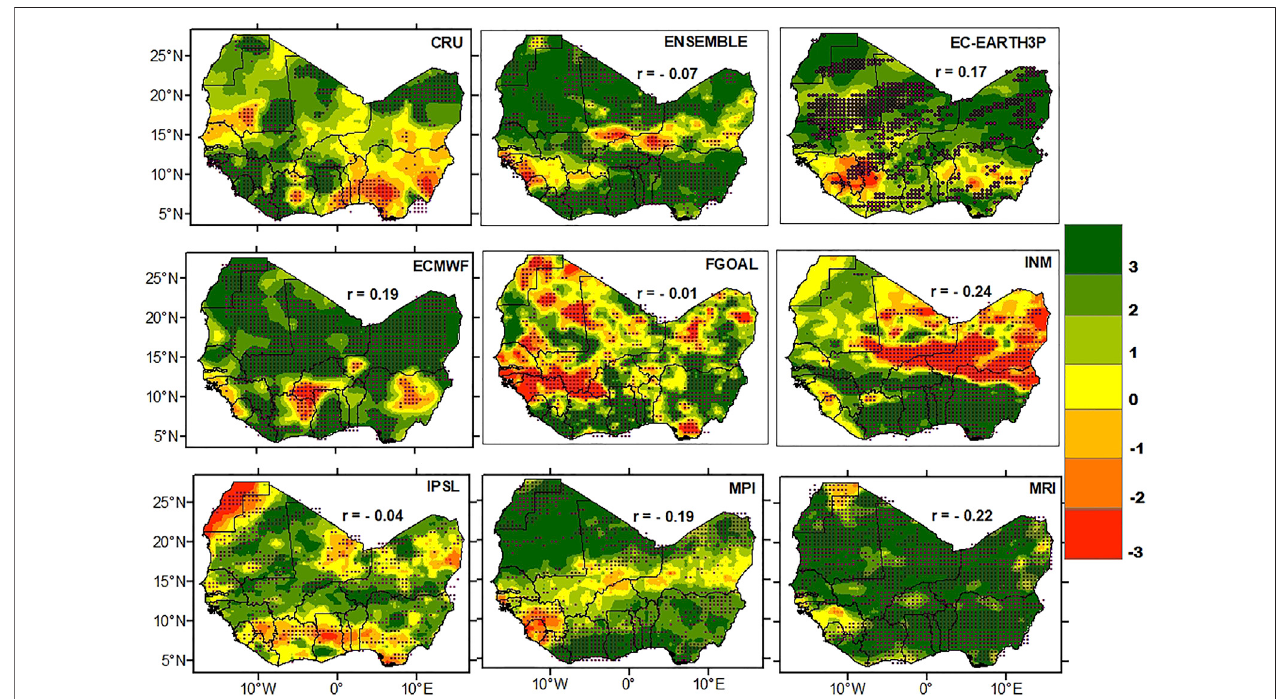
FIGURE 10 | Same as Figure 8 but for SPEI-12.